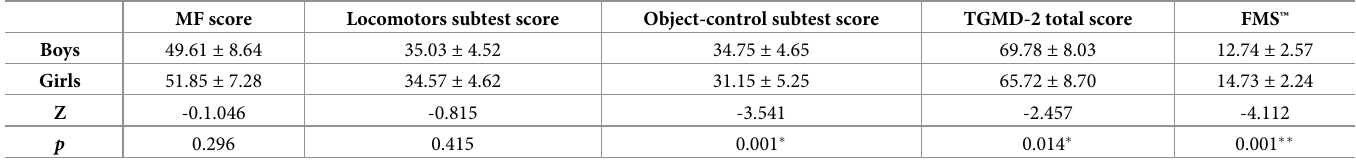
Table 4. Gender analyses of MF test, TGMD-2, and FMS ™ (mean ± SD). MF